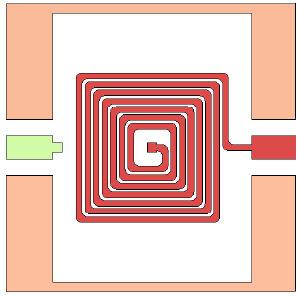
Figure 1: Square spiral inductor with guard plane shielding